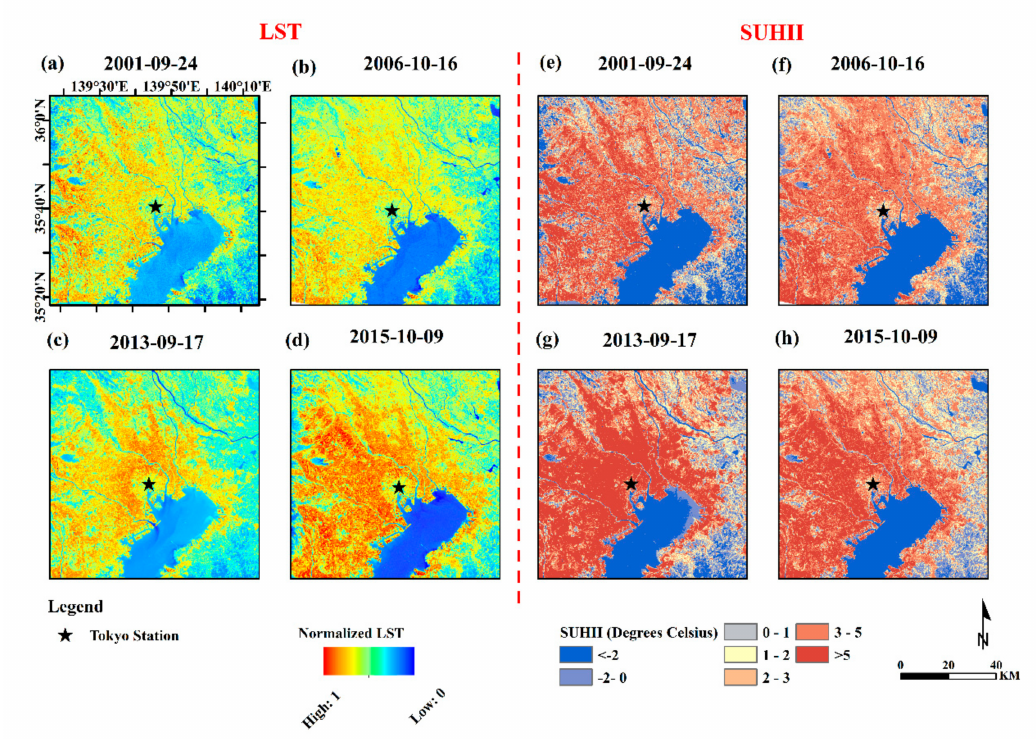
Figure 4. Spatiotemporal evolution of the urban thermal environment in TMA from 2001–2015: ( a – d ) spatiotemporal patterns of LST, and ( e – h ) spatiotemporal patterns of SUHI